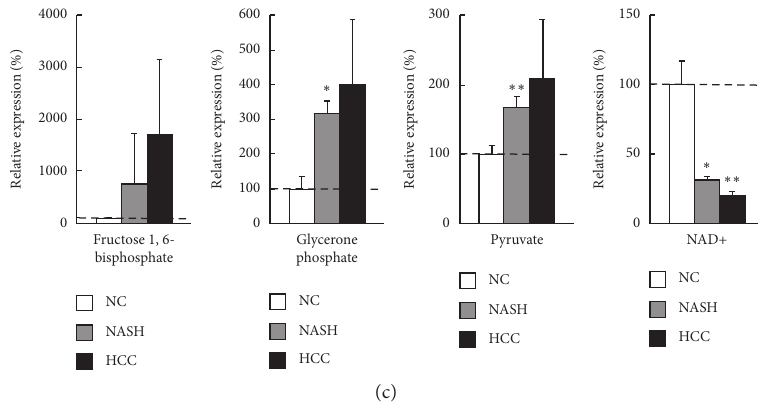
Figure 3: Gene expression analysis and metabolomics of liver samples from mouse NASH-HCC model. (a) Quantitative RT-PCR analysis of metabolic genes related to glycolysis, FA synthesis and uptake, and TG synthesis in cancer tissues (HCC) and noncancer tissues (NASH) from melanocortin-4 receptor-deficient (MC4R–KO) mice fed a western diet for 60 weeks. The gene expression levels were normalized to those of wild-type (WT) mice as normal control (NC) and were presented as mean ± SE. ∗ p < 0 . 05 and ∗∗ p < 0 . 01 vs. NC. (b) Heat map analysis of metabolomics in NC, NASH, and HCC. It was generated by coloring the values of all data across their value ranges. The color red demonstrated that the relative content of metabolites is high and green demonstrates that they are low. The brightness of each color corresponded to the magnitude of the difference when compared with the average value. (c) The amounts of glycolysis-related metabolites and NAD + in NASH and HCC normalized to those in NC were presented as mean ± SD. ∗ p < 0 . 05, ∗∗ p < 0 . 01 vs. NC. NASH, nonalcoholic steatohepatitis; HCC, hepatocellular carcinoma; G6PD, glucose-6-phosphate dehydrogenase; PK, pyruvate kinase; ACC, acetyl-coenzyme A carboxylase; FAS, fatty acid synthase; SREBP, sterol regulatory element-binding protein; PPAR, peroxisome proliferator-activated receptor; NAD, nicotinamide adenine